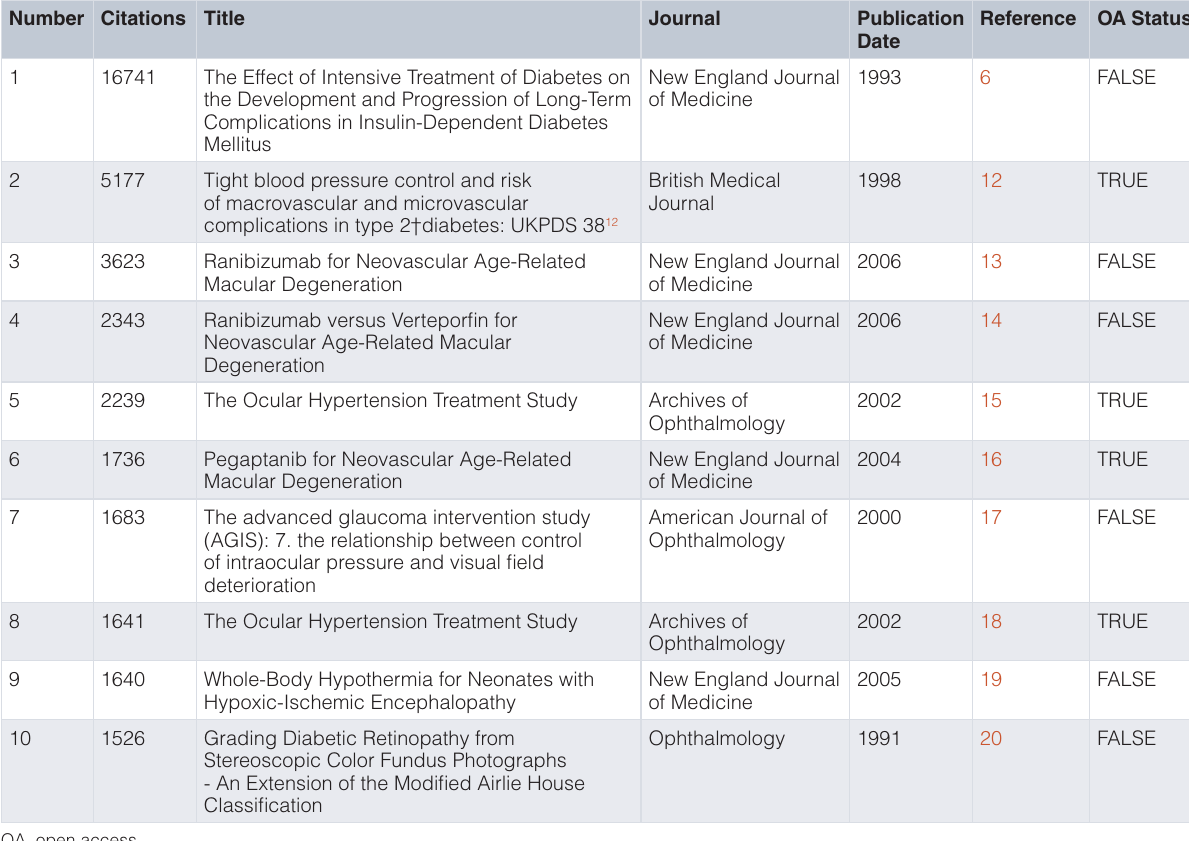
Table 1. The 10 randomized controlled trials with the highest number of citations.